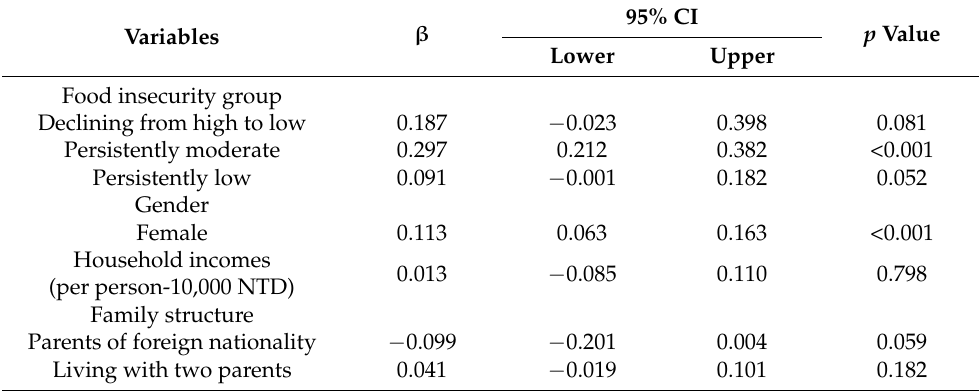
Table 2. The association between mental health problems and food insecurity trajectory.